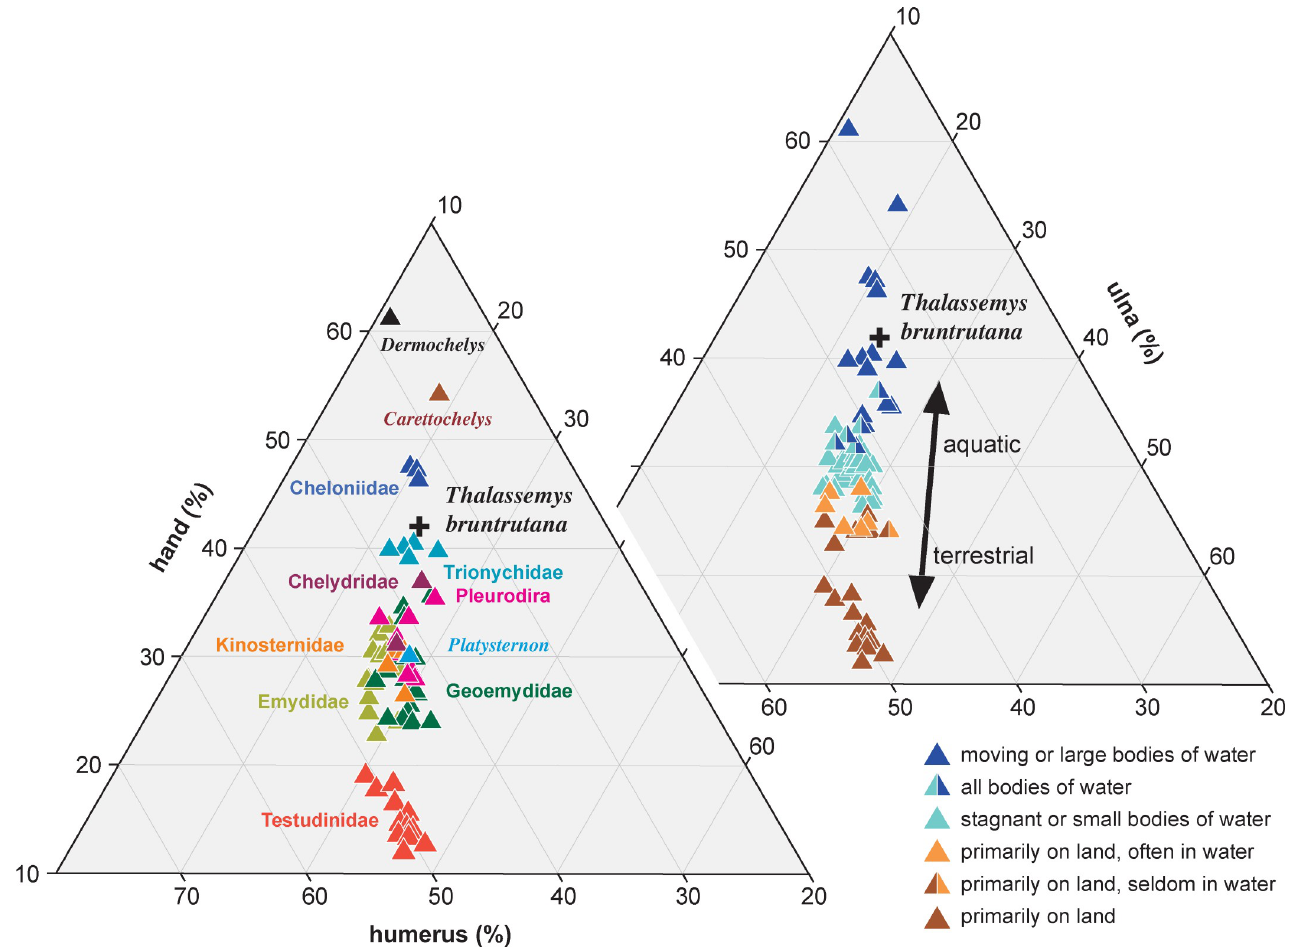
Fig 5. The relative length of the humerus, ulna, and hand of Thalassemys bruntrutana relative to that of extant turtles. In the diagram to the front, extant turtles are color coded for taxonomic groups, in the diagram to the back, extant turtles are color coded for habitat preferences. All data of extant turtles are taken from Joyce and Gauthier (2004) [11]. Note that Thalassemys bruntrutana has relatively longer hand that extant trionychids, but shorter hands that extant carettochelyids and chelonioids.